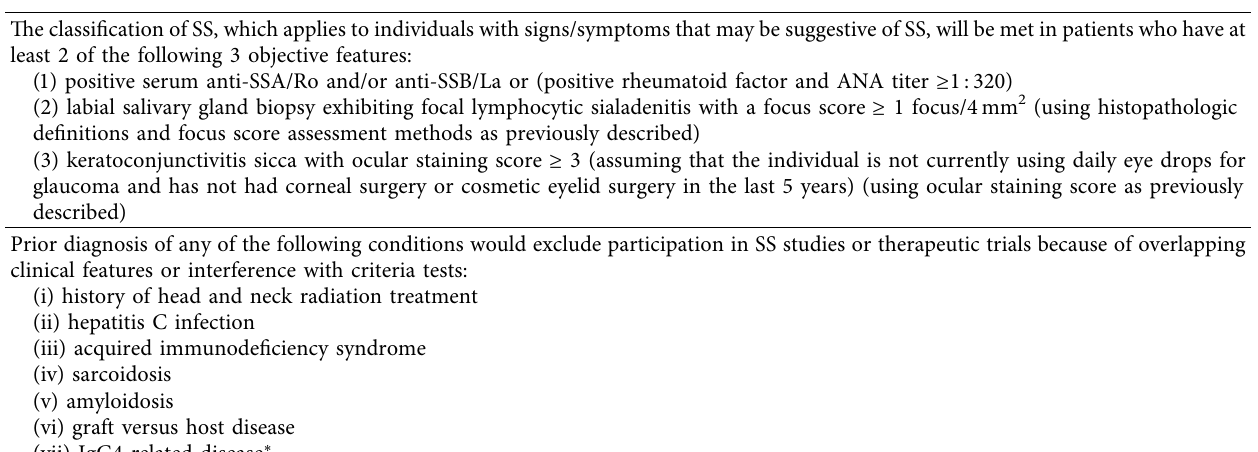
Table 3: 2012 classification criteria for SS by ACR [10].